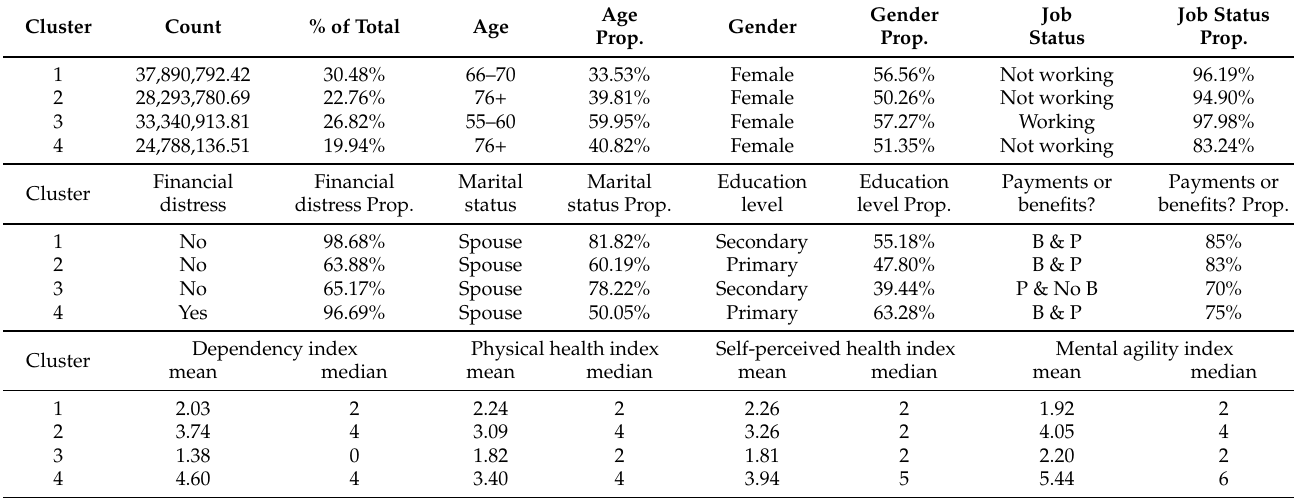
Table 3. Summary statistics of the variables used to create the profiles, per